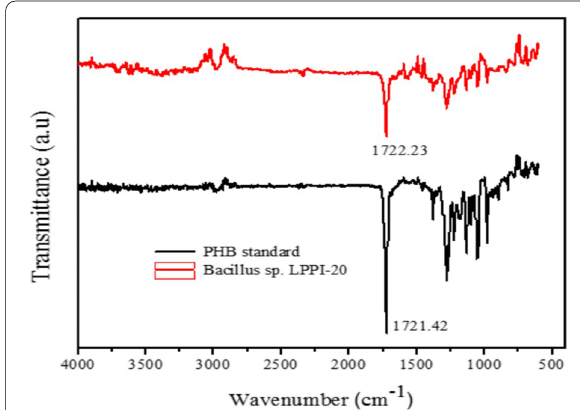
Fig. 9 Fourier transforms infrared spectrum of the Bacillus sp. BPPI-14 polymer, Bacillus sp. LPPI-18, and standard PHB (Sigma). Note: The functional group of FTIR analysis of extracted polymers from Bacillus sp. LPPI-18 was closely related to the functional group of standard PHB